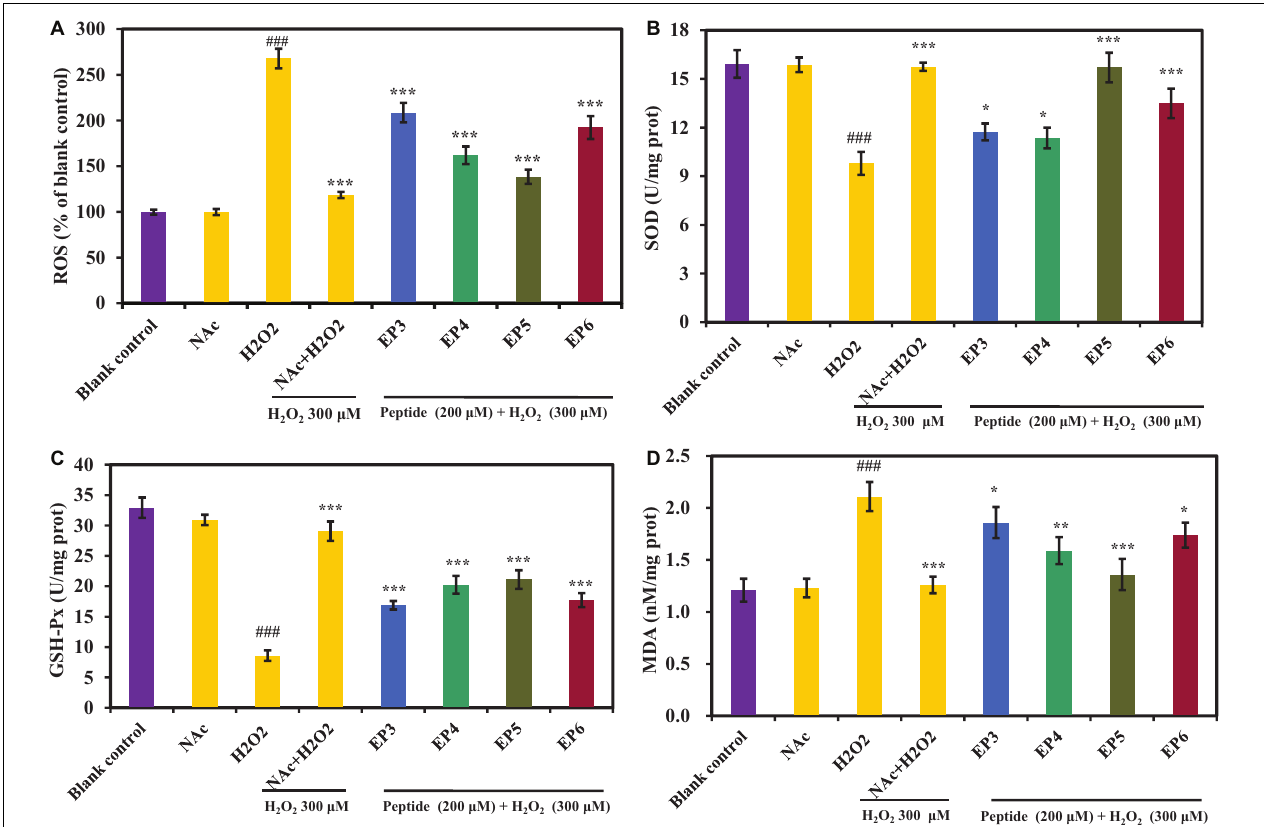
FIGURE 7 | Effects of the antioxidant peptides (EP3–EP6) on the levels of reactive oxygen species (ROS) (A) , superoxide dismutase (SOD) (B) , glutathione peroxidase (GSH-Px) (C) , and malondialdehyde (MDA) (D) in oxidative damage HUVECs at the concentration of 200 µ m. Blank control refers to the levels of ROS, SOD, GSH-Px, and MDA in normal cells; NAc column refers to NAc on normal cells at the concentration of 100 µ m; H 2 O 2 column refers to H 2 O 2 -induced oxidative damaged model (300 µ m for 6 h); NAc + H 2 O 2 refers to NAc treated with H 2 O 2 -induced HUVEC model cells at the concentration of 100 µ m; peptide + H 2 O 2 refers to EP3–EP6 treated with H 2 O 2 -induced oxidative damaged model cells at the concentration of 200 µ m, respectively. The data were presented as the mean ± SD ( n = 3). ### p < 0.001 vs. the blank control group; ∗∗∗ p < 0.001, ∗∗ p < 0.001, and ∗ p < 0.05 vs. the H 2 O 2 -treated group.